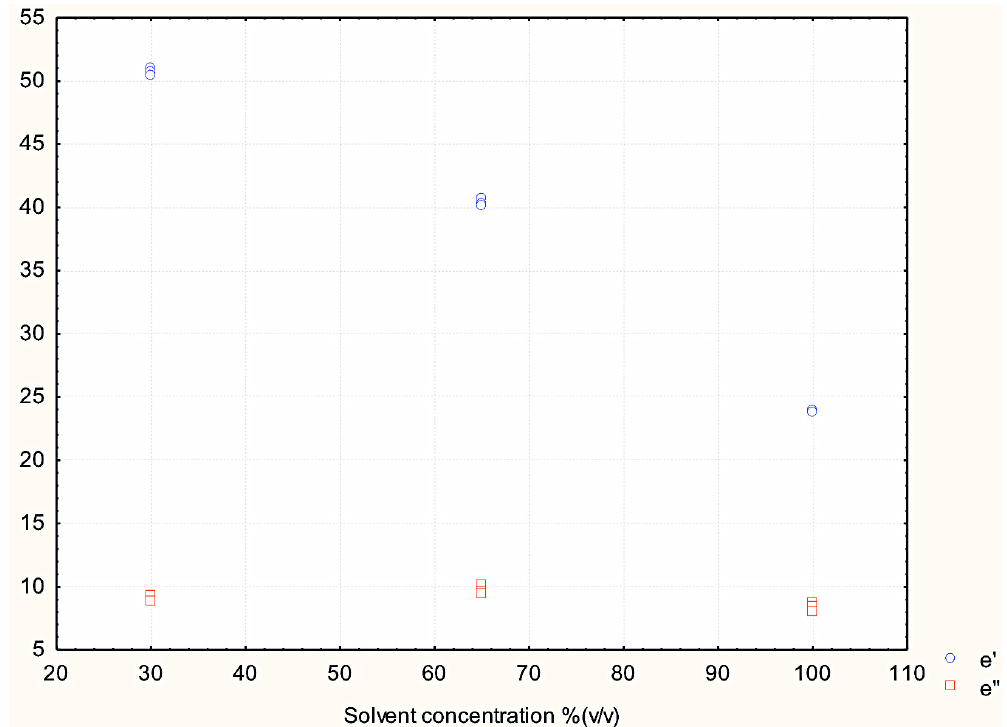
Figure 8. Effect of solvent concentration (v/v) on its dielectric constant and loss factor (Source: Adapted from